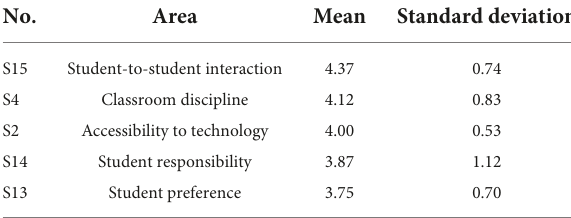
TABLE 8 Teachers’ perceptions associated with student considerations in the FL.